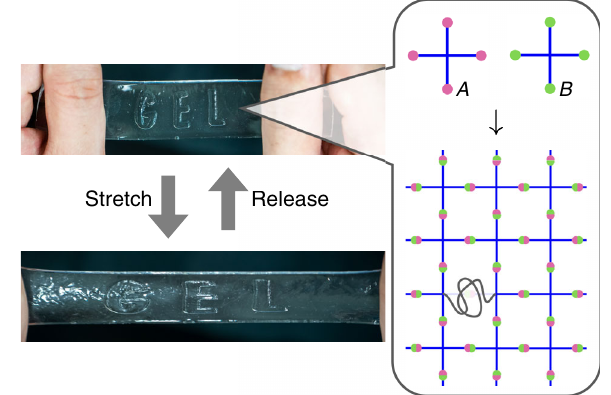
FIG. 2. Highly stretchable rubberlike hydrogel with a homo- geneous model network (tetra-PEG gel). This gel is synthesized by AB -type cross-end coupling of two kinds of precursors of the same size. These precursors are tetra-armed poly(ethylene glycol) (PEG) chains whose terminal functional groups ( A and B ) are mutually reactive.